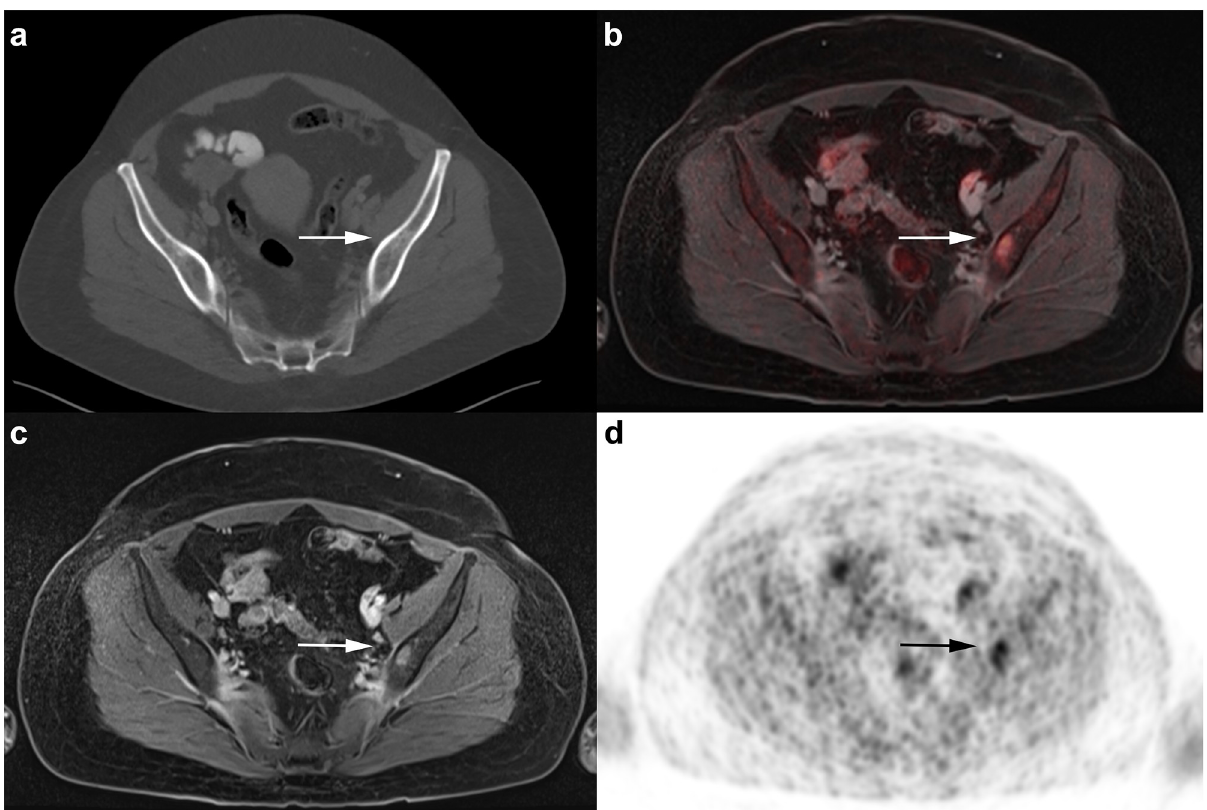
Fig 2. A 45-year old woman with diagnosis of primary breast cancer. No distant metastases were detected in the CT scan ( a ). The subsequently performed 18 F-FDG PET/MRI shows a bone metastasis in the left iliac bone with contrast enhancement on T1w fs VIBE ( c ) and pathological FDG uptake on PET ( d ) and fused 18 F-FDG PET/MRI ( b ).